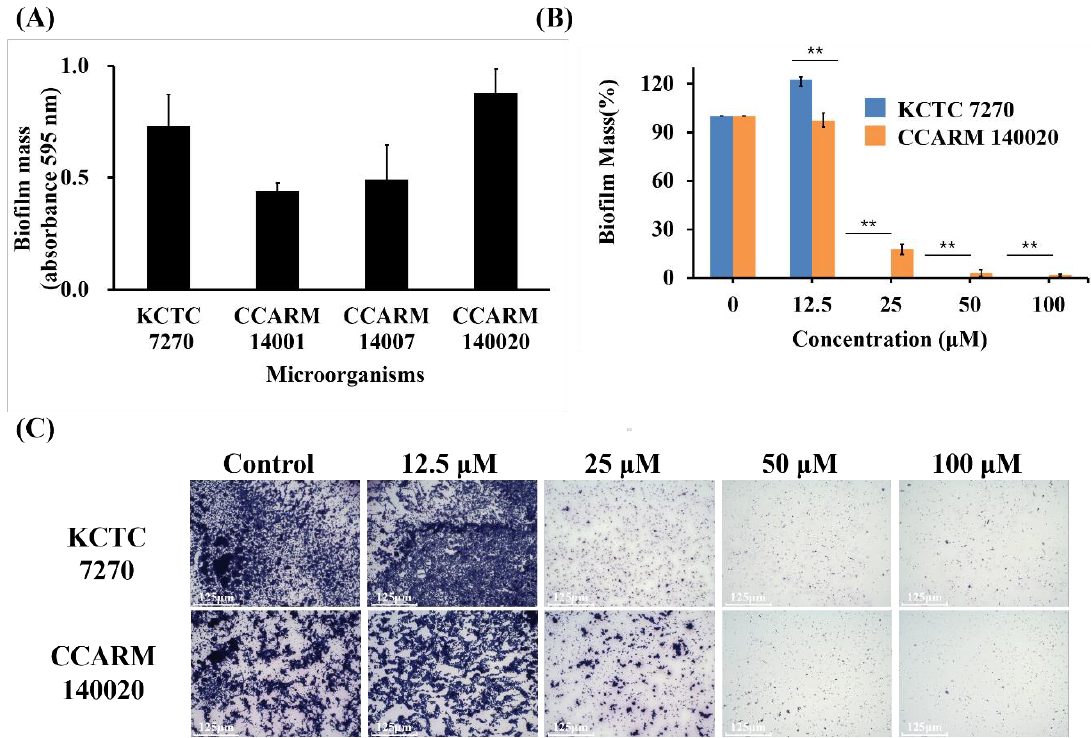
Figure 5. Inhibition of C. albicans biofilm formation by KW 4 . ( A ) Quantitative measurement of the biofilm formation for four strains. ( B ) Comparison of the inhibitory effect of KW 4 addition on biofilm formation. ( C ) Microscopic analyses of biofilms formed by C. albicans stained with 0.1% crystal violet and the effects of treatment with KW 4 at various concentrations. Columns indicate the means, bars show the SEM ( n = 3). Scale bar = 125 μm. ** p < 0.01 versus control (two-tailed Student’s t -test).